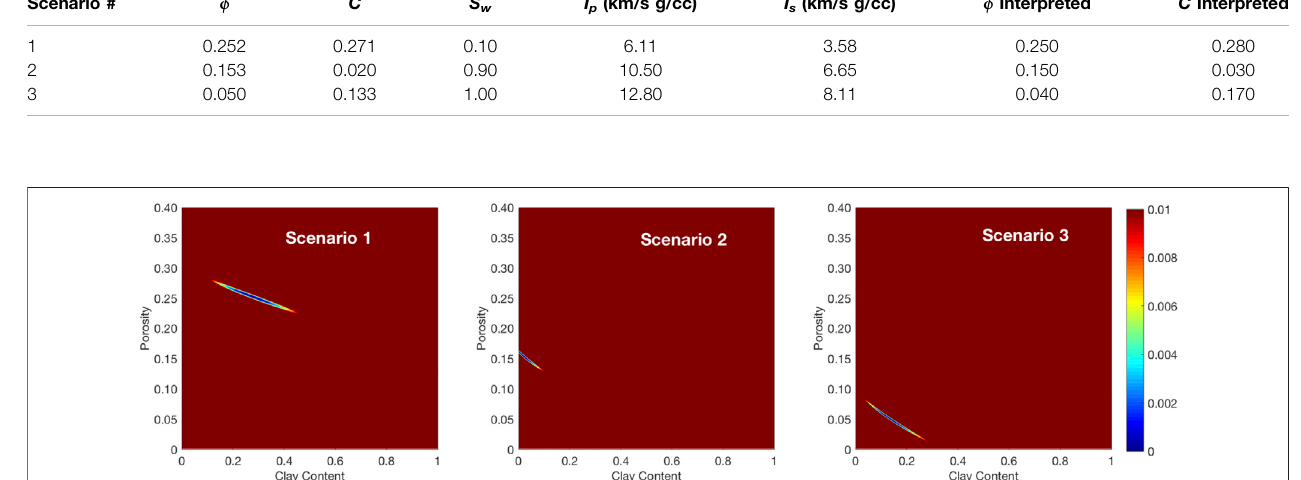
TABLE1| Inputs(porosity ϕ ,claycontent C ,andwatersaturation S w )forforwardmodelingscenariosusingtheRaymeretal.(1980)modelandthecomputedP-andS-wave impedances ( I p and I s , respectively). Scenario #